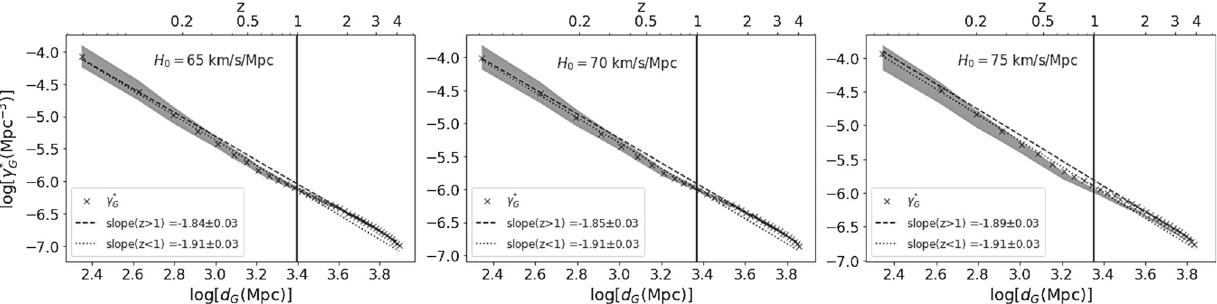
Fig. 9 Log–log graph of γ ∗ vs. d G obtained with the SPLASH galaxy redshift survey dataset in the ranges z < 1 and 1 ≤ z ≤ 4 and respective G distance